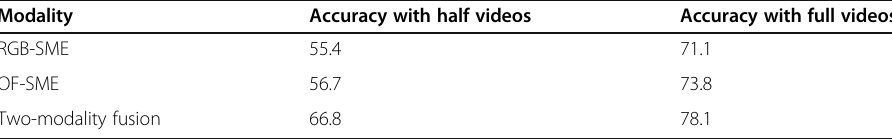
Table 3 Prediction accuracy comparison of different modalities on sub-JHMDB (%)